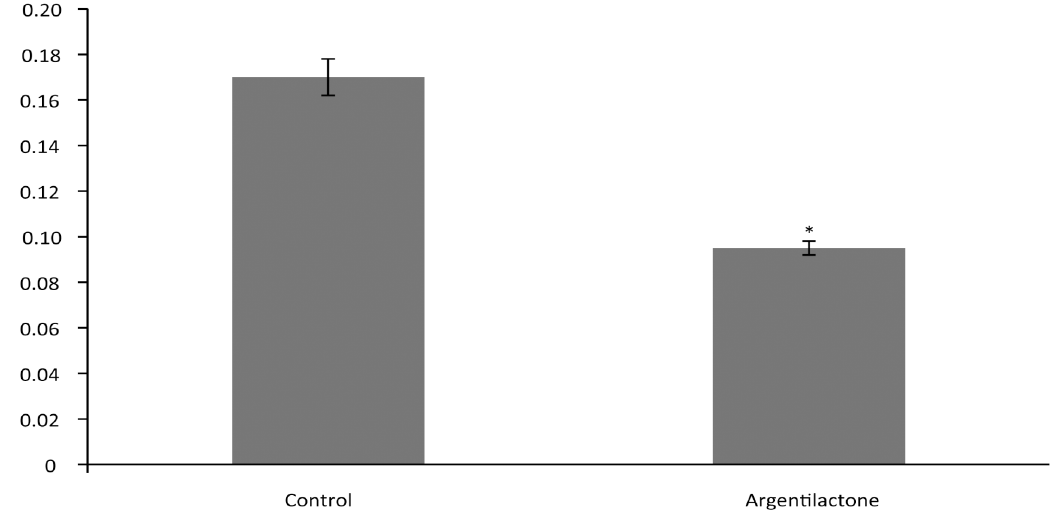
Fig 2. Ethanol dosage in Paracoccidioides lutzii under the action of argentilactone. A total of 10 6 cells were used for each sample, and the ethanol levels in the presence and absence of argentilactone were quantified using enzymatic detection. The data are expressed as the mean ± standard deviation of biological triplicates of independent experiments. Student's t -test was used. * , significantly different from the carbon condition at a p- value of (cid:1)